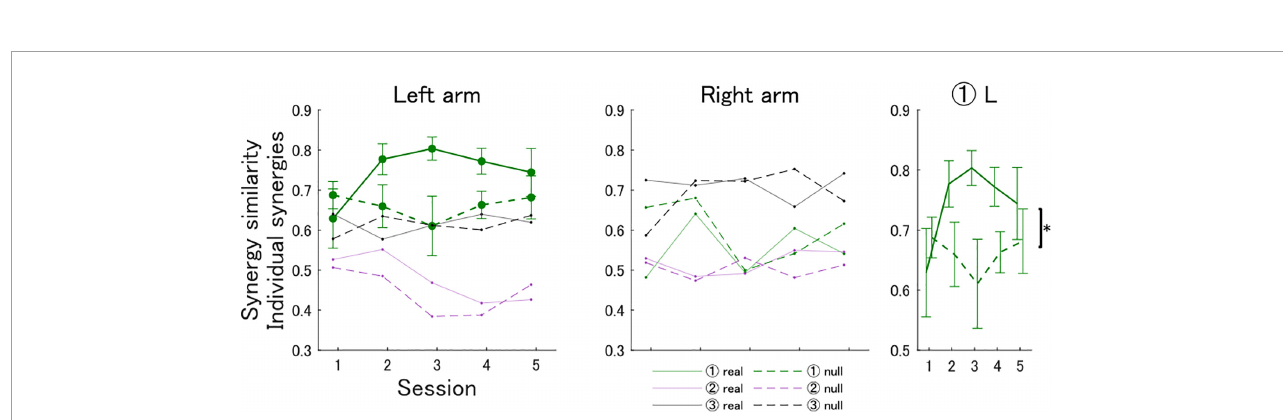
FIGURE5 Cosine similarity metric of individual unimanual synergies in the real and null feedback groups. The first and second panels show the similarity metric for the left and right arms, respectively. Solid and dashed lines show the results for the real and null feedback groups, respectively. The third column summarizes statistical comparisons. The asterisk indicates a significant effect of feedback type on the similarity of synergy 1 of the left arm to the corresponding expert